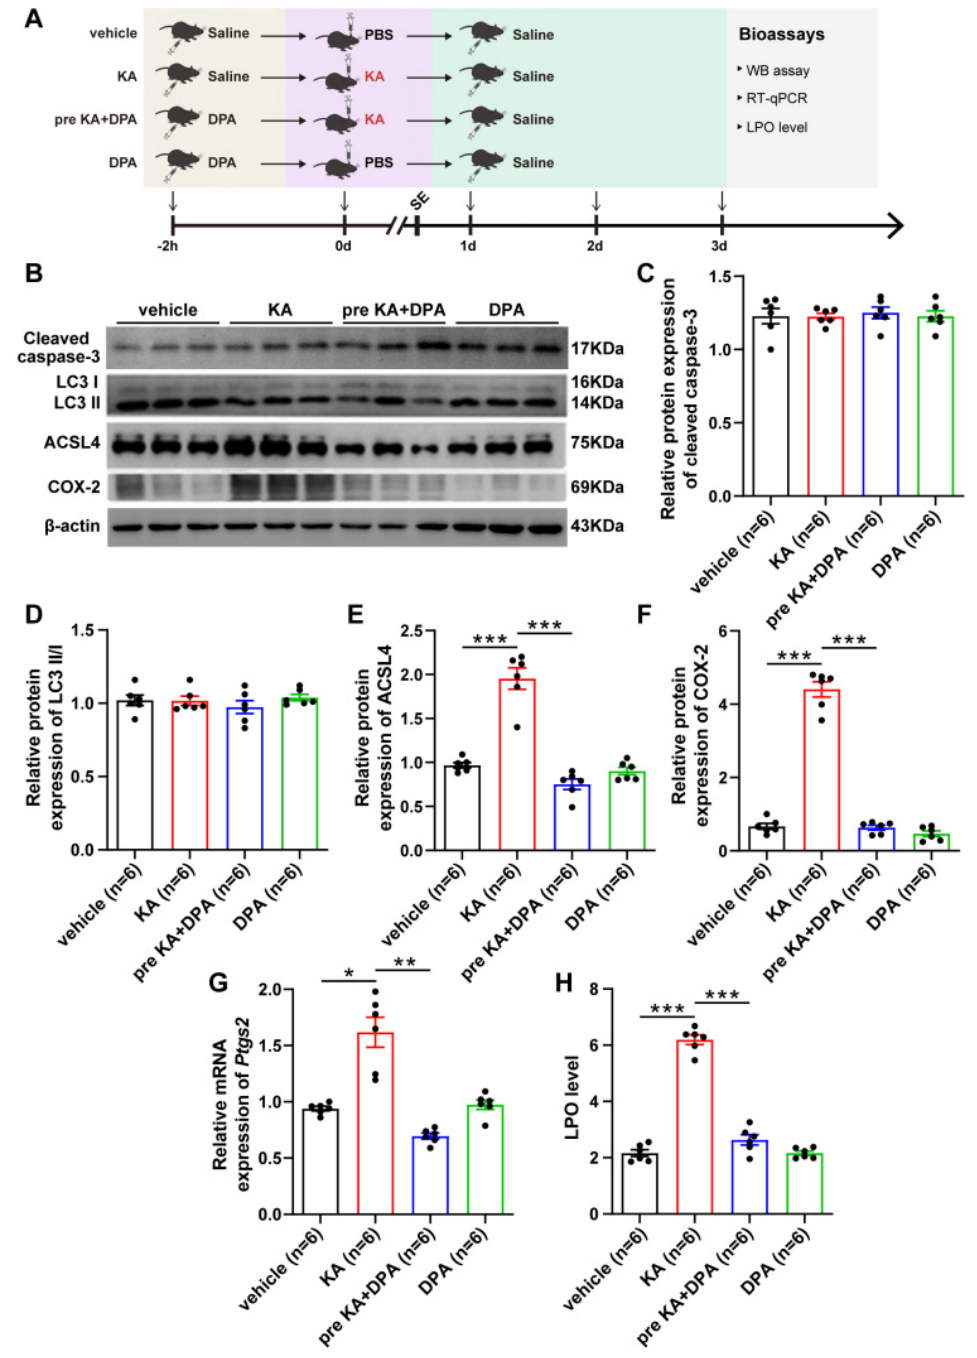
Figure 2. Ferroptosis is involved in the protection of DPA against KA-induced seizure mice . ( A ) Experimental scheme. Bioassays including WB, RT-qPCR and LPO detection were conducted 3 d after KA (250 ng/ μ L) or PBS injection. ( B – F ) Representative WB images and statistical analysis of protein expression in the hippocampus showing the effects of DPA on indices of apoptosis (cleaved caspase-3), autophagy (LC3II/I) and ferroptosis (ACSL4 and COX-2) in mice subjected to KA. ( G , H ) Effects of DPA on other ferroptosis indices including Ptgs2 mRNA and LPO level in mice subjected to KA. All the data were expressed as mean ± SEM ( n = 6). * p < 0.05, ** p < 0.01 and *** p < 0.001. Abbreviation: DPA, D-penicillamine; KA, kainic acid; SE, status epilepticus; PBS, phosphate buffered saline; LPO, lipid peroxide; RT-qPCR, real-time quantitative PCR; WB, Western blot; IF, immunofluorescence; ACSL4, acyl-coA synthetase long chain family member 4; COX-2, cyclooxygenase-2; Ptgs2 , prostaglandin-endoperoxide synthase